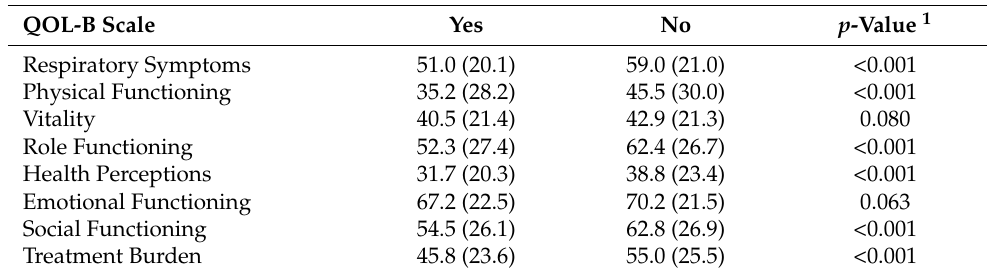
Table 5. Discrimination of QOL-B scores, stratified by Pseudomonas aeruginosa infection at baseline and/or in the previous 12 months.